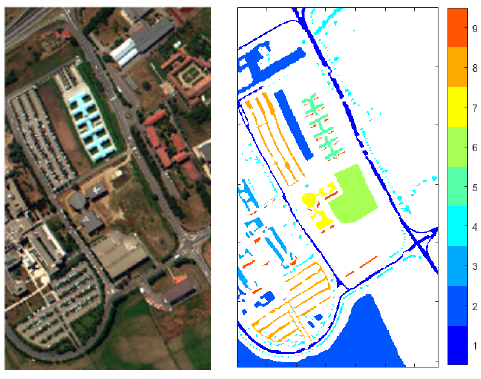
Figure 3. Hyperspectral Pavia University image and its ground-truth